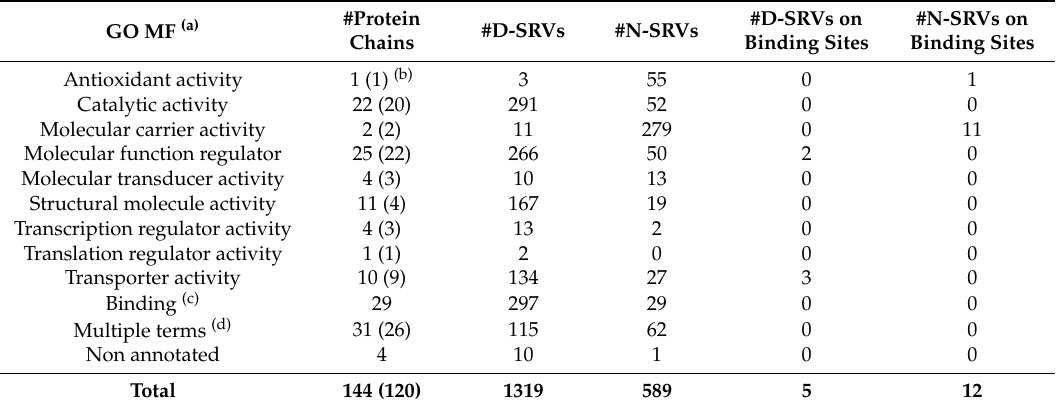
Table 4. HVAR3D: Functional characterization of 144 protein chains lacking enzyme commission (EC) numbers.